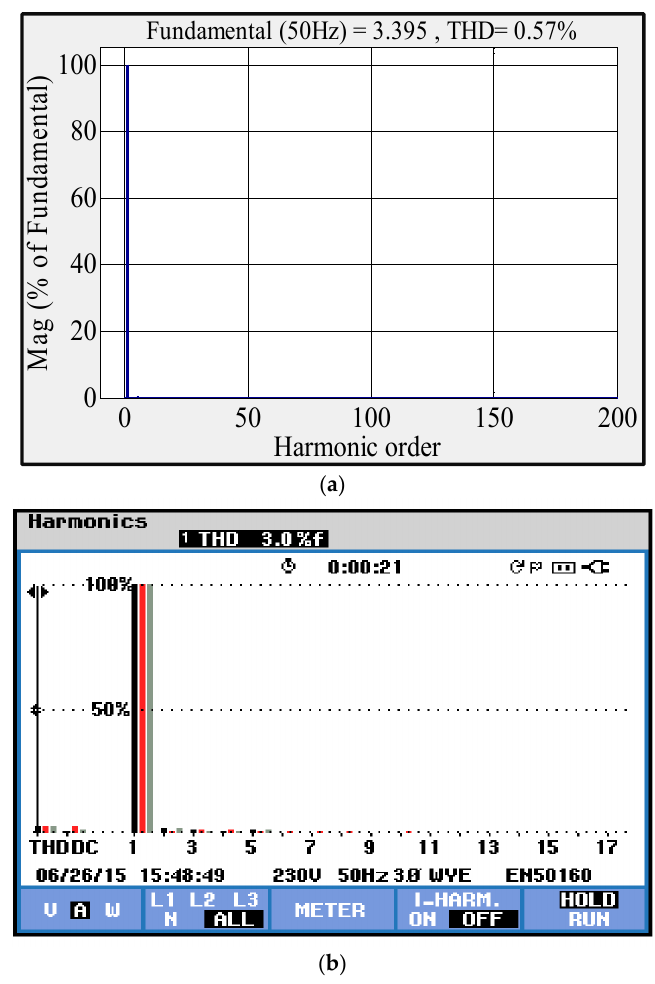
Figure 17. THD for the phase current of the three-phase inverter with R load for ( a ) simulation and ( b ) experimental.